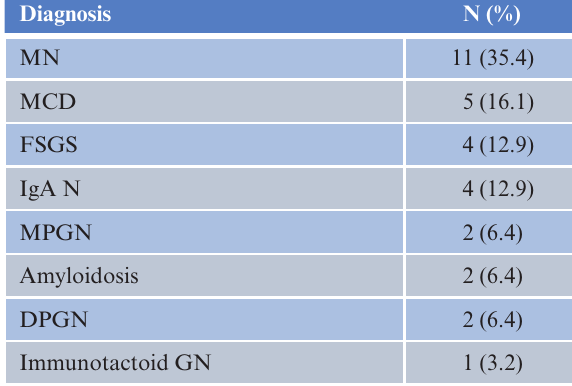
Table 2: Biopsy spectrum of nephrotic syndrome in the elderly.